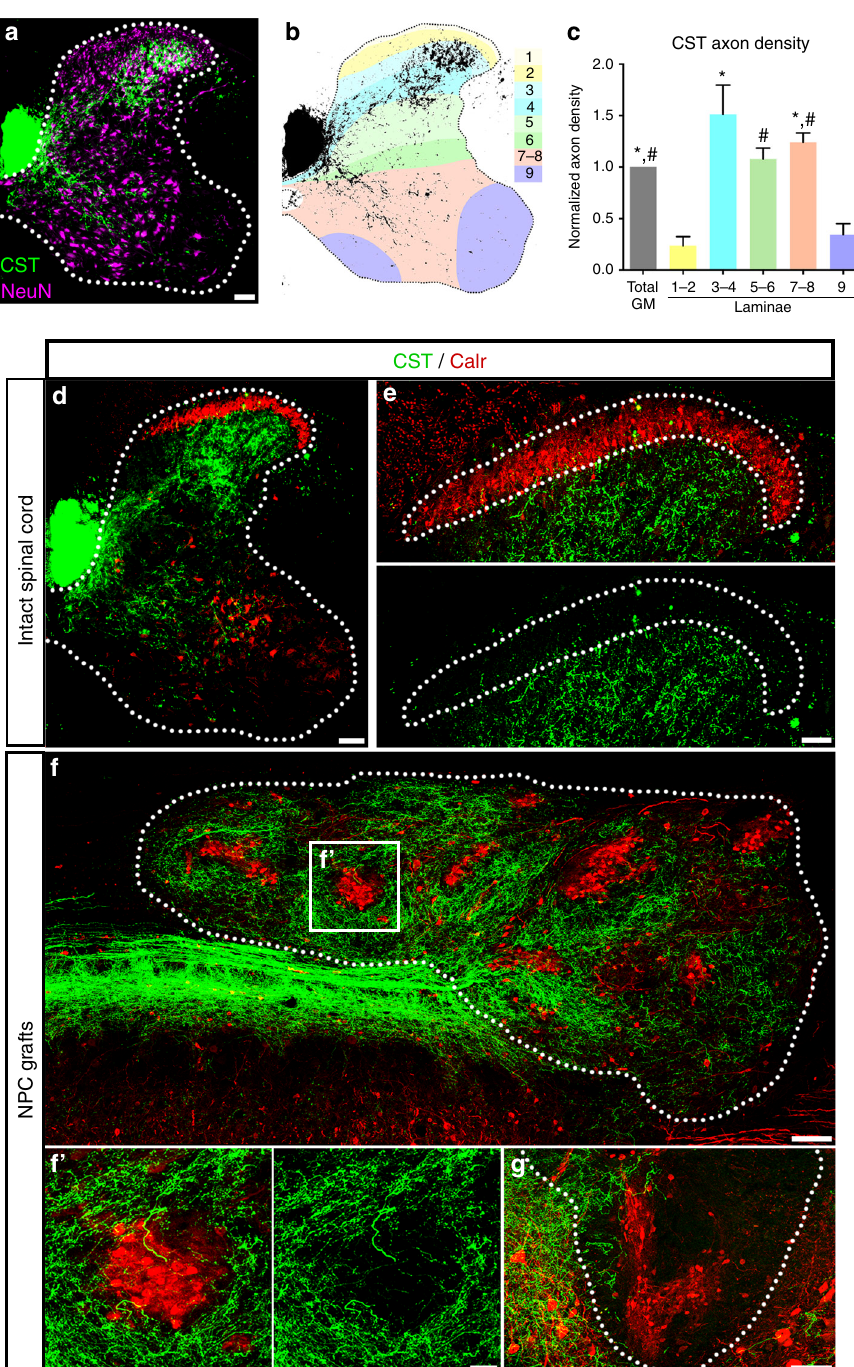
Fig. 4 Graft-derived laminae I – II domains are avoided by host corticospinal axons. a Representative image of corticospinal tract (CST) axon (green) termination within the intact cervical spinal cord of age P35 rat; neurons labeled with NeuN (magenta). Border of spinal cord gray matter indicated with dotted lines. b Cartoon illustrating distribution of corticospinal axons (black) against map of Rexed laminae I – IX. c Quanti fi cation of CST axon density within laminae I – IX; data are expressed as mean ± SEM and normalized to CST axon density in total gray matter (GM); *p < 0.05 vs. laminae I – II and # p < 0.05 vs. lamina IX by one-way ANOVA followed by Tukey ’ s post-test for multiple comparisons; n = 4. d , e Labeling of CST axons (green) and calretinin (red) in the intact C4 spinal cord. e High-magni fi cation image of CST axons in the intact dorsal horn. Dotted lines in e indicate border of calretinin immunoreactivity. f CST axons (green) regenerate extensively into spinal cord NPC graft (dotted line). CST axons are attenuated within regions of graft tissue with calretinin + domains (red). g Calretinin + domain (red) near the rostral graft/host interface appears to block deeper penetration of CST axons (green) into graft (dotted line). Scale bars = 100 μ m ( a , d , f ), 50 μ m ( e , g ), 25 μ m ( f ’